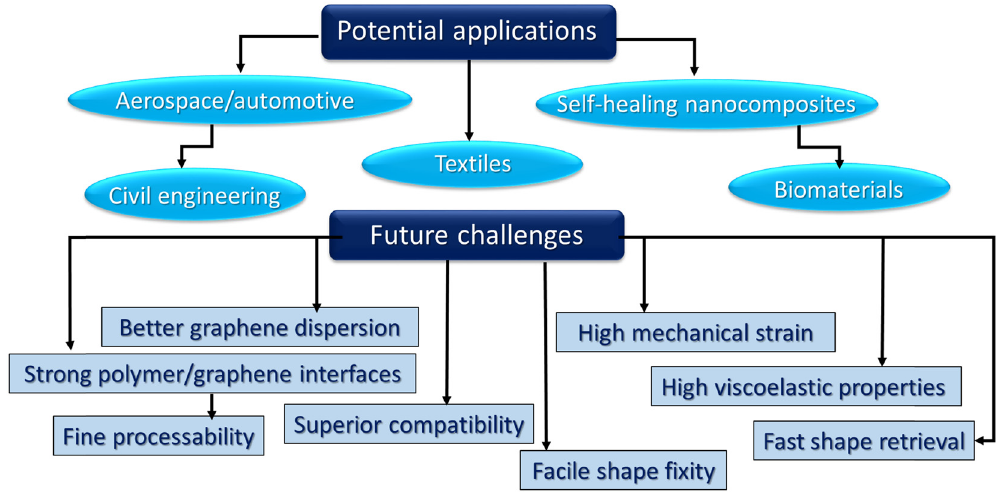
Figure 16: Schematic of the potentials and challenges of shape memory polymer/graphene